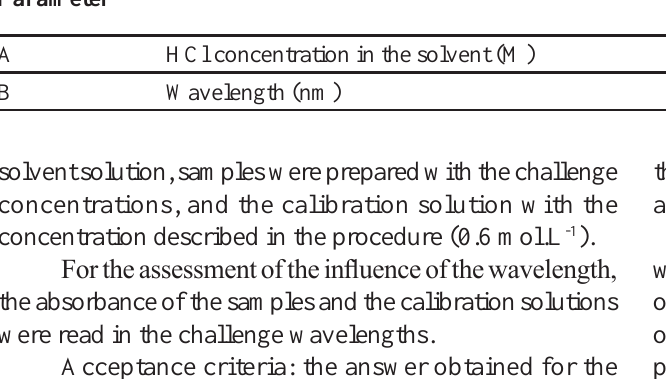
TABLE I – Parameters evaluated in the robustness of the procedure